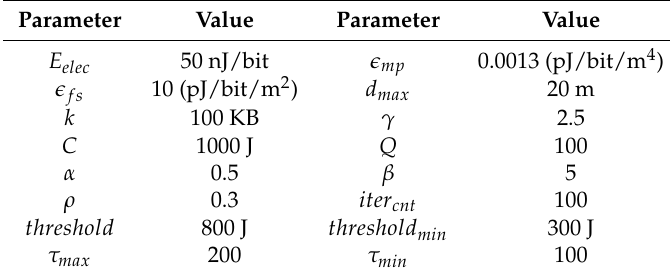
Table 1. Parameters in the simulation.